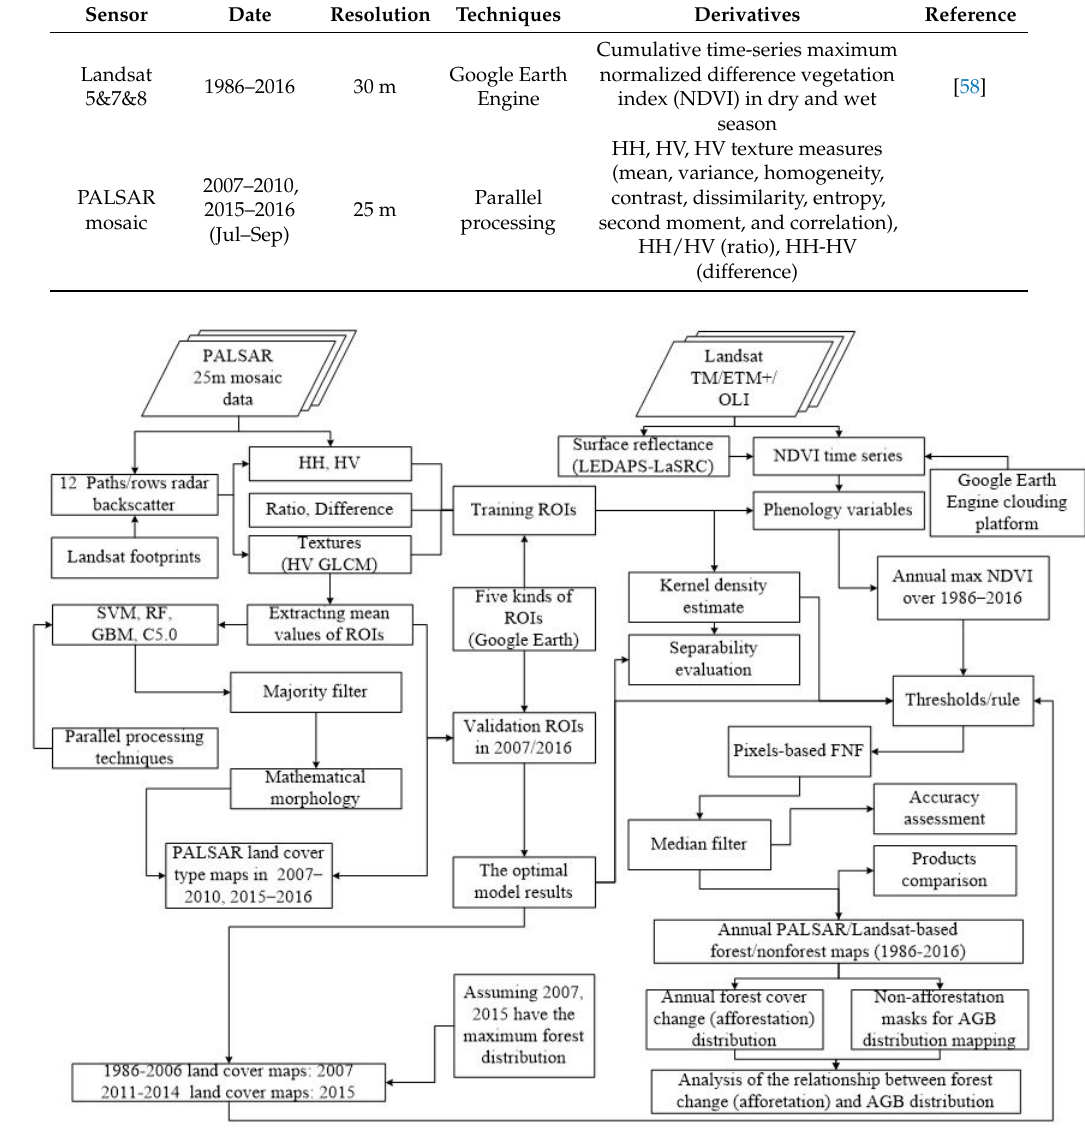
Figure 2. The detailed flowchart for mapping annual PALSAR/Landsat-based forest/non-forest (1986–2016). First, support vector machine (SVM), random forest (RF), gradient boosting machines (GBM), and C5.0 based on PALSAR mosaic data was applied together with training and validation ROIs from Google Earth to generate five types of land cover maps. Second, the integration of PALSAR and Landsat-based maximum normalized difference vegetation index (NDVI) was used to generate PALSAR/Landsat-based forest/non-forest maps and improved the mapping accuracy. Finally, annual forest cover change due to afforestation was developed and to explore the relationship with forest aboveground biomass dynamics (AGB)